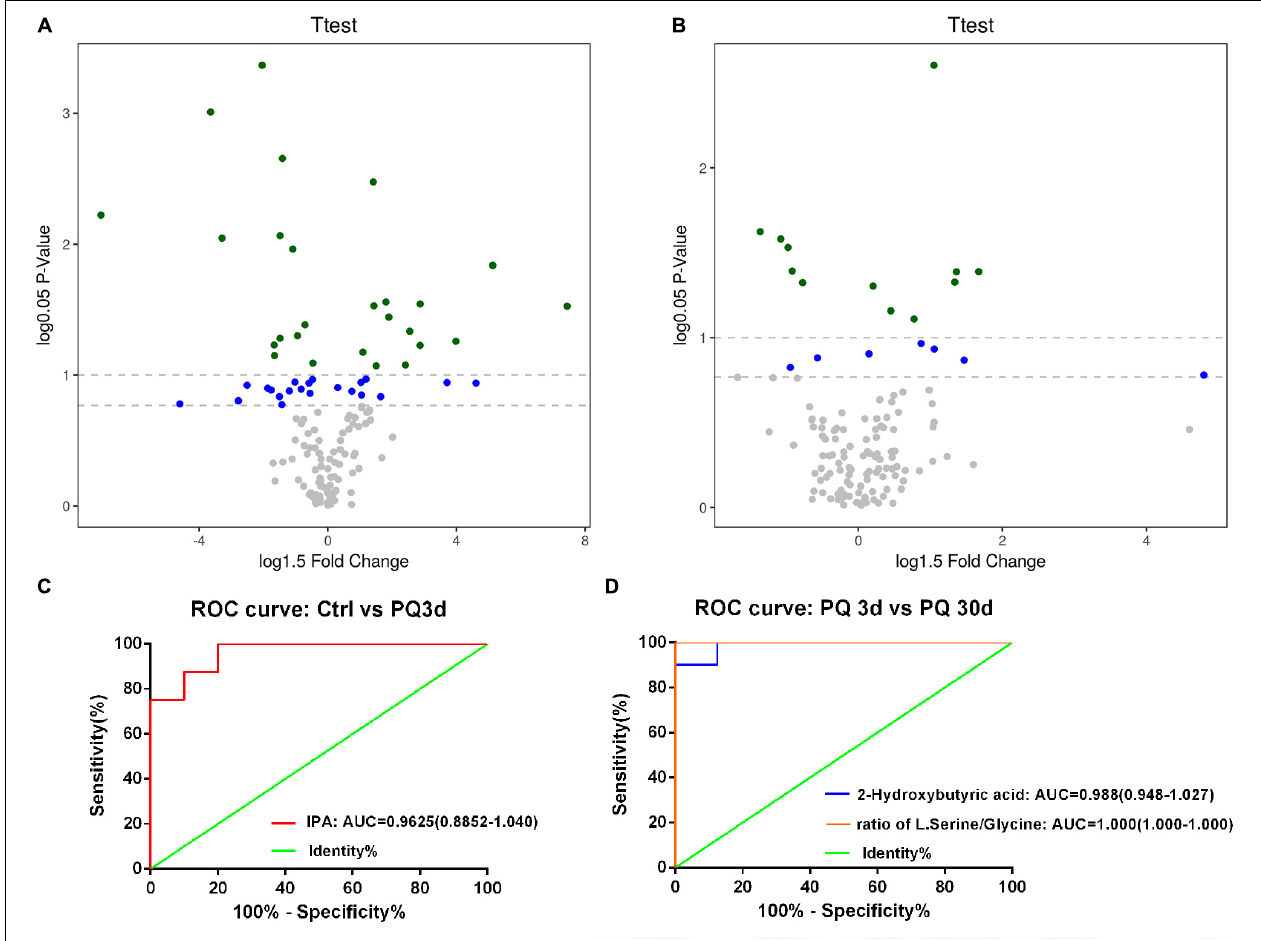
FIGURE 2 | Identification and performance assessment of metabolites with significance. An enhanced volcano plot showed the differential metabolites selected with multi-criteria assessment from PQ3d vs. Ctrl (A) and PQ30d vs. Ctrl (B) . The P -value together with log 1.5 fold change (FC) was introduced with a cutoff value of 0.05, 0.1 for P -value and 1.5 for log 1.5 FC, respectively. ROC curve of IPA distinguishing PQ3d vs. Ctrl (C) , 2-hydroxybutyric acid, and the ratio of L -serine/glycine (D) distinguishing PQ3d vs. PQ30d. The AUC values of each metabolite were shown below each ROC curve. Confidence interval (CI) was enclosed in parentheses after AUC